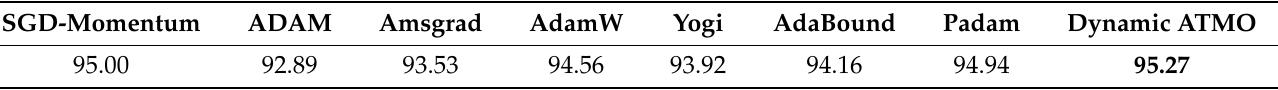
Table 1. Best accuracies in percentage to compare ATMO (that combines Padam and SGD) and the results published in [18] using a Resnet18 on the Cifar10